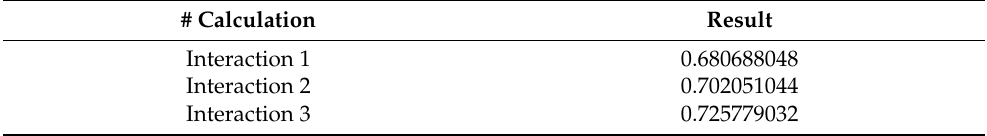
Table 13. Second analysis and result of Cronbach’s alpha of three